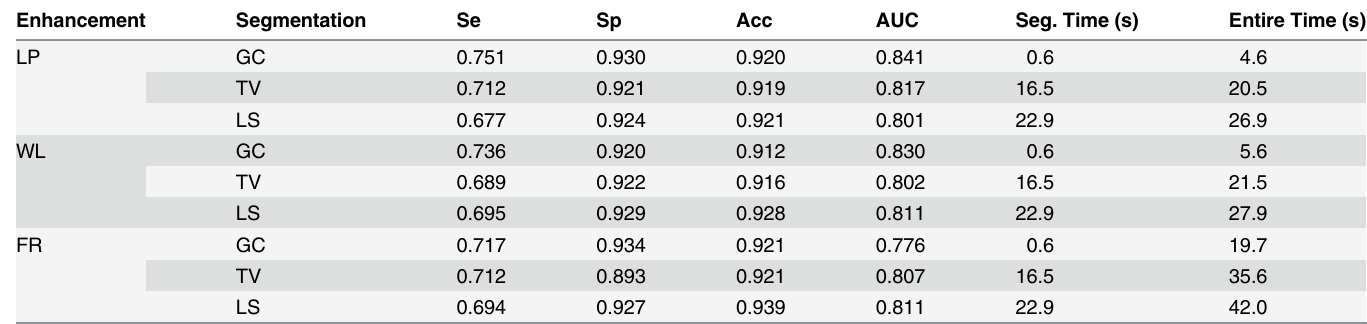
Table 4. Segmentation performance of different possible combinations of three enhancement methods (LP, WL, FR) and three segmentation meth- ods (GC, TV, LS) on the ARIA dataset. LP, WL and FR denote local phase, wavelet and Frangi ’ s eigenvalue based enhancement filters respectively. GC, TV and LS denote graph cut, total variation and level set based segmentation methods respectively. Se : sensitivity; Sp : specificity; Acc : accuracy; AUC : area under the curve.